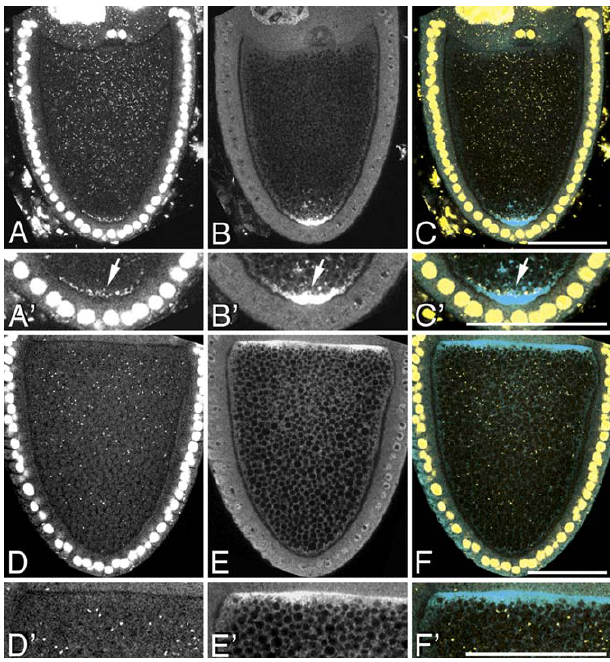
Figure 3. wMel in Oocytes That Exhibit Wild-Type and Ectopic Osk Localization (A–F) Full-size oocytes and (A’–F’) corresponding expanded views of the posterior cortex are shown. Rows: (A–C, A’–C’) wMel in a wild-type oocyte, (D–F, D’–F’) wMel in an osk 54 /oskDf (3R)p-XT103 oocyte carrying the osk-bicoid 3’UTR transgene. Columns: (A, A’, D, D’) propidium iodide stain, (B, B’, E, E’), Osk antibody stain, (C, C’, F, F’) merged image showing propidium iodide (yellow) and Osk (cyan). Arrows indicate wMel and Osk co-localization. Scale bars ¼ 25 l m.